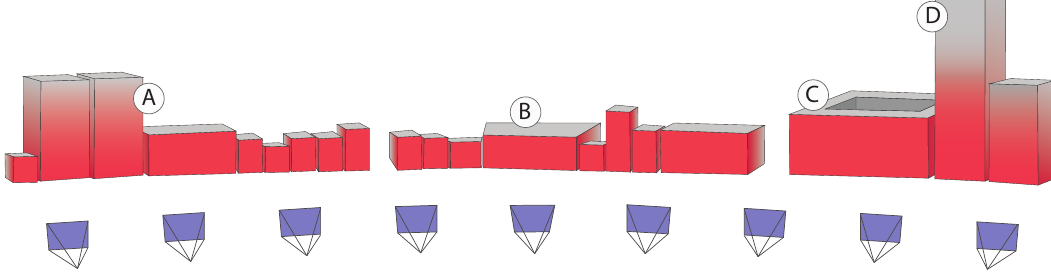
Figure 1. Diagram representing a typical terrestrial campaign. In particular, Points A and D denote areas that were negatively affected. High buildings are only partially observed in this type of acquisition. B and C, show details of characteristics that cannot be observed either by the type of imaging (only street-side view) or because they are internal structures, such as winter gardens (highlighted in